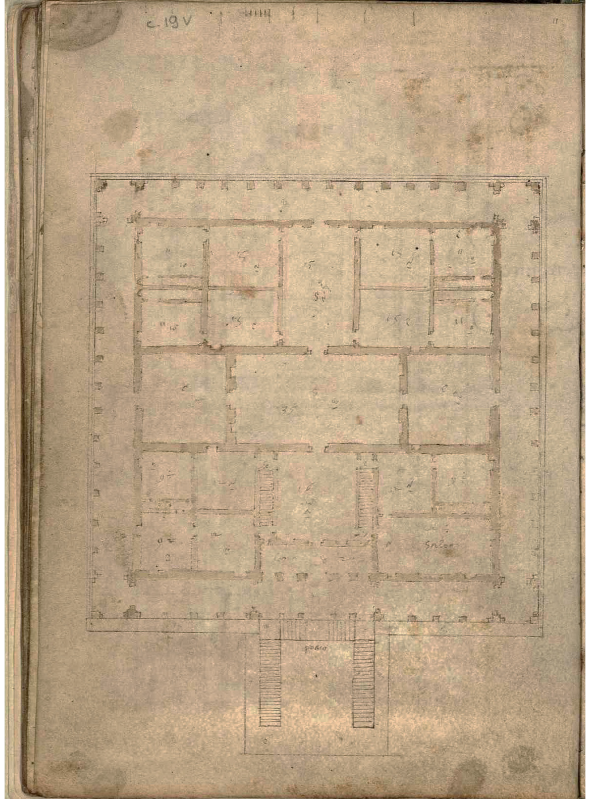
Figure 1. The original drawing by Giuliano da Sangallo.“Progetto in pianta per la Villa Medicea Poggio a Caiano” as portayed in the “Taccuino